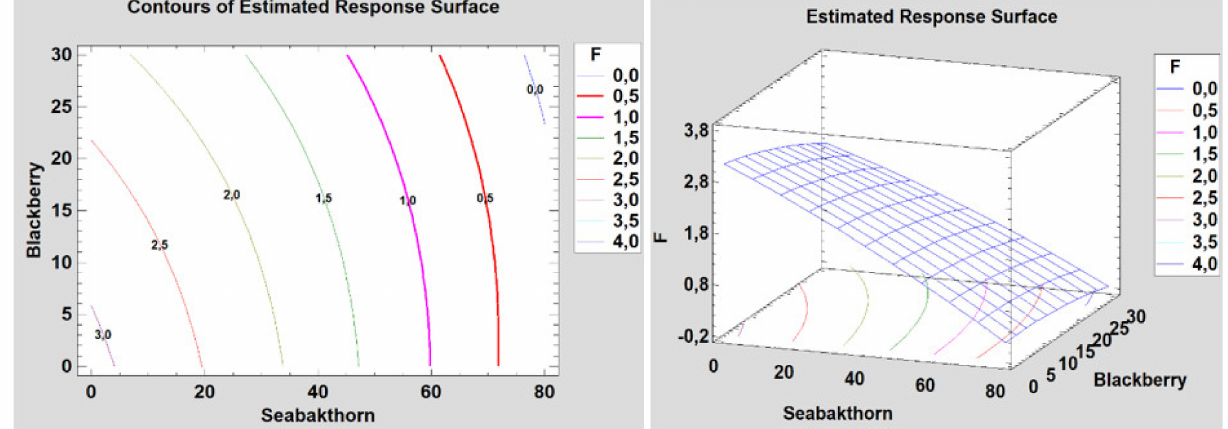
Figure 3. Graphic representation of the dependence of the content of fine fraction according to the percentage of the constituents of the raw material (seabuckthorn biomass + blackberry + straw).